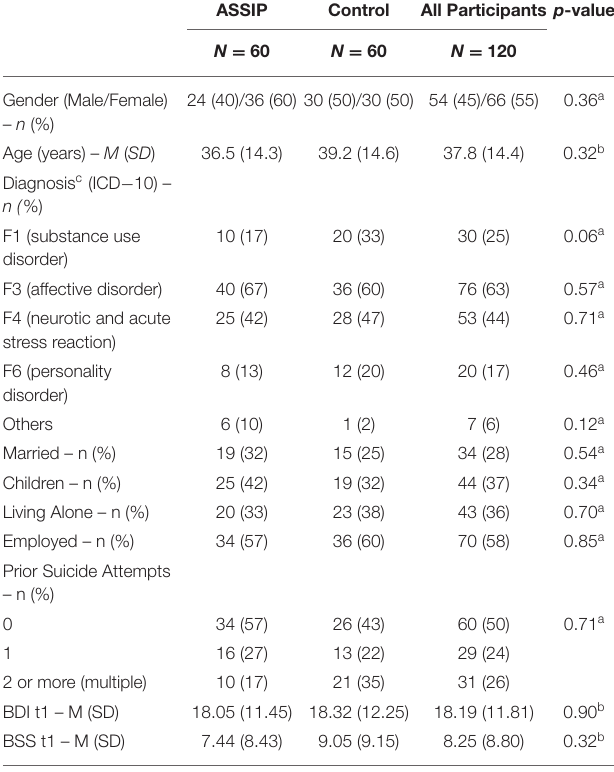
TABLE 1 | Sociodemographic and clinical characteristics of study participants at baseline.